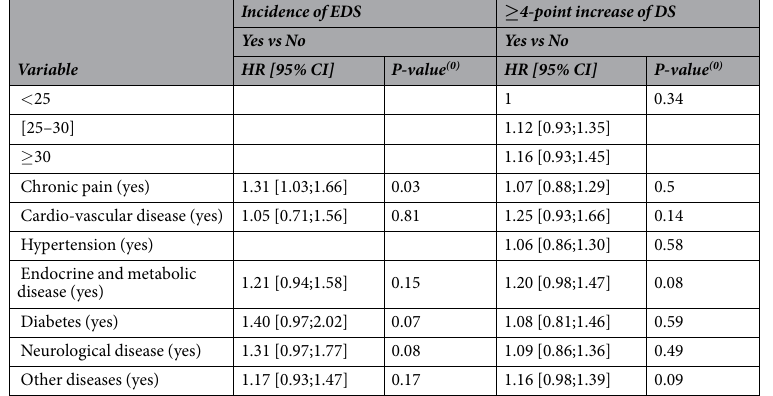
Table 3. Common analyses of the associations between potential predictors and incidences of excessive daytime sleepiness (EDS) and of a 4-point increase of daytime sleepiness (DS) during the 5-year follow-up. (0) Only baseline ESS score, age, gender and variables associated at p < 0.15 in univariate analysis were entered into the